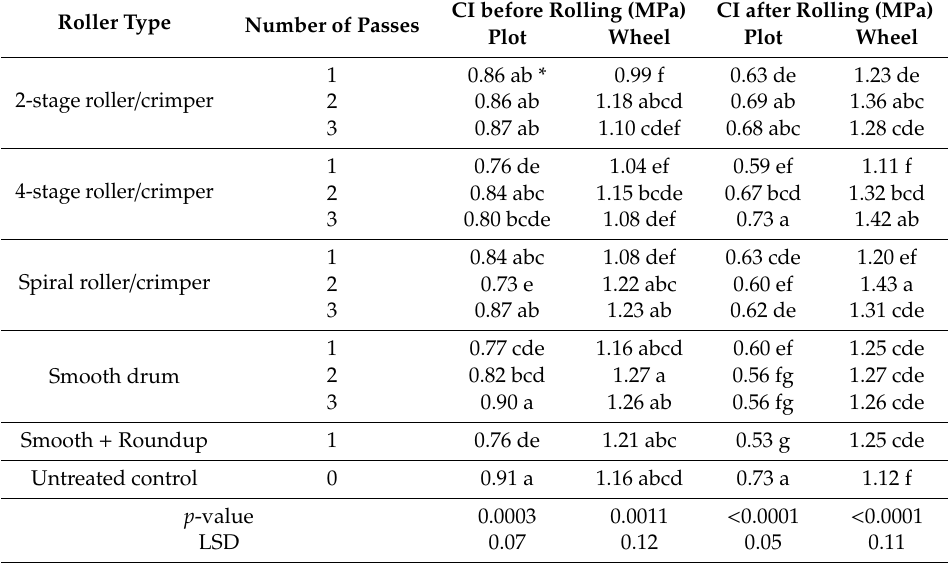
Table 13. Soil cone index (CI) values averaged over depth (0–30 cm) in 2016 growing season for each roller type and number of passes.